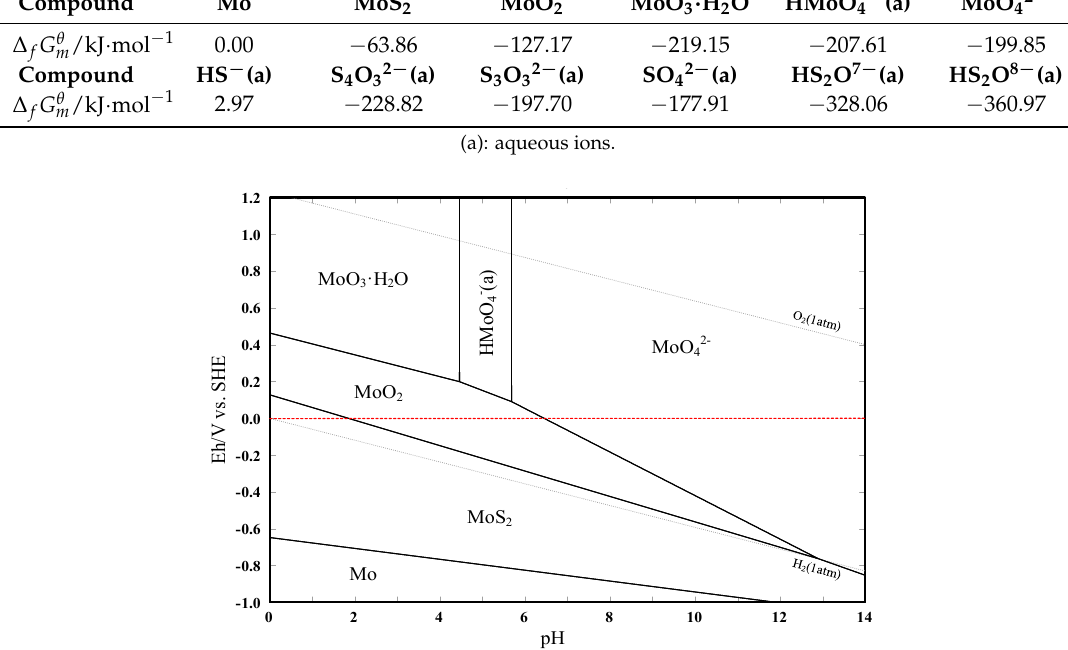
Figure 9. The Eh–pH diagram for the Mo-S-H 2 O system. Conditions: 1 × 10 − 4 M molybdenum, 2 × 10 − 4 M sulfur, 298.15 K, 1 atm.